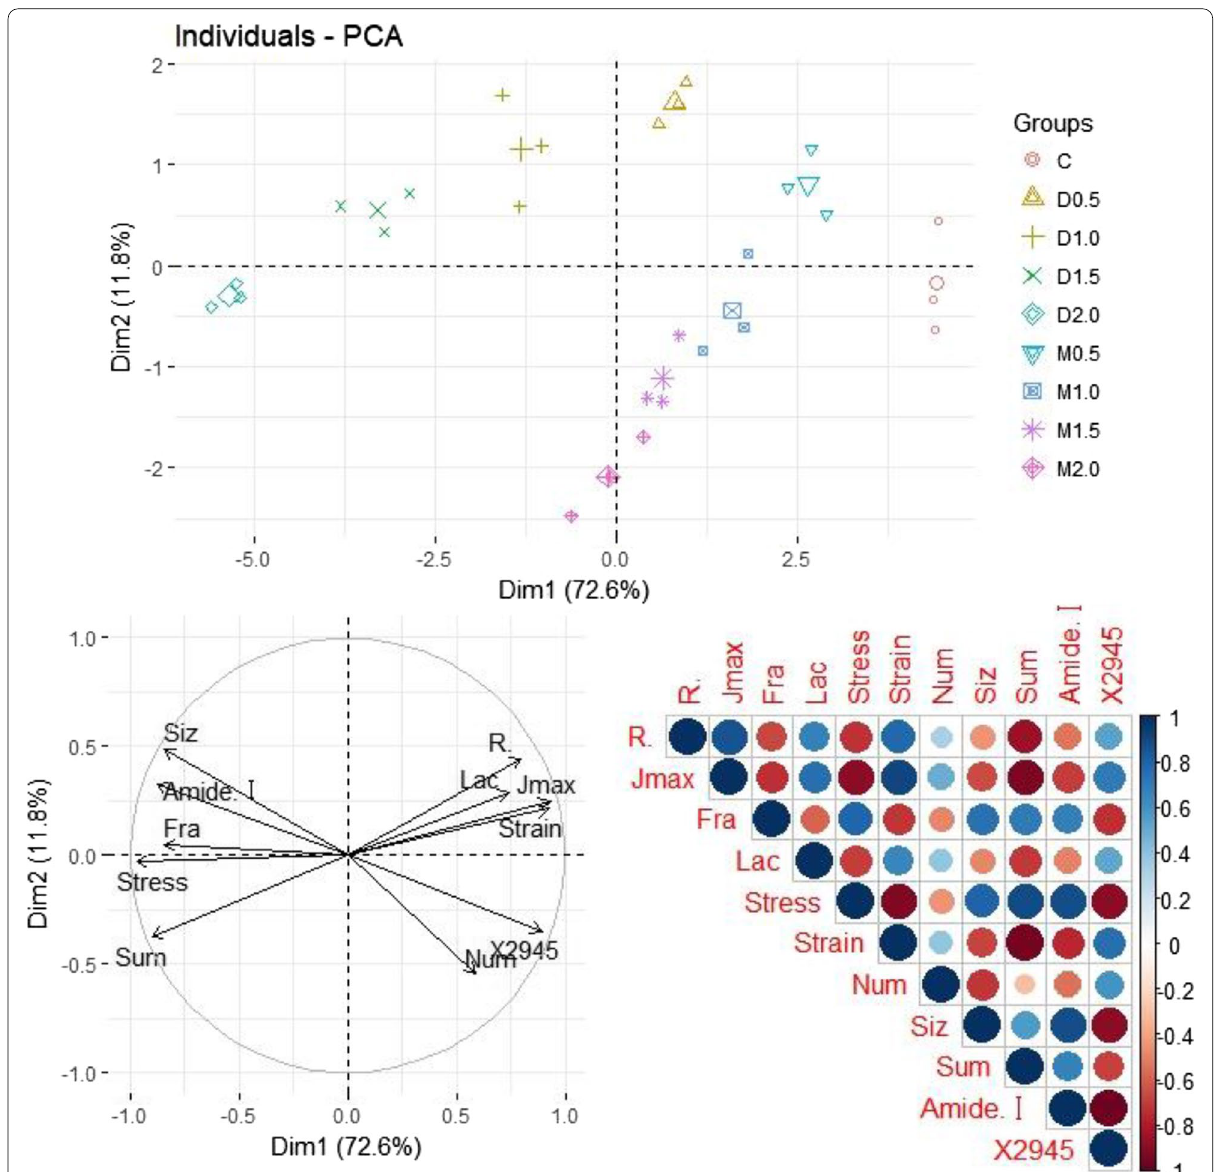
Fig. 6 Results of the Principal Component analysis score plots in the PC1 vs. PC2 plane ( A ); Principal Component analysis loading plots in the plane of PC 2 vs. PC 1 ( B ). Correlation among the fracture property and microstructure of composite gel ( C